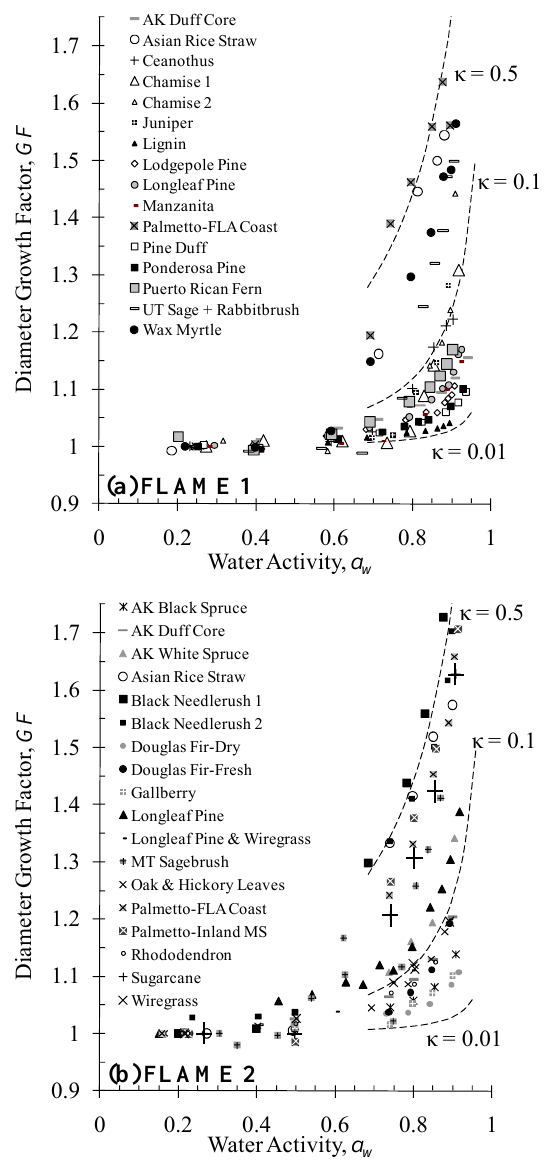
Figure 4. Compilation of chamber burn ensemble GF as a function of a w for D d = 100 nm particles 3 Fig. 4. Compilation of chamber burn ensemble GF as a func- tion of a w for D d =100nm particles during (a) FLAME 1 and (b) during (a) FLAME 1 and (b) FLAME 2. Error bars indicating the estimated uncertainties of the 4 FLAME 2. Error bars indicating the estimated uncertainties of the measurement are shown in panel (b) for sugarcane. (AK=Alaska, measurement are shown in panel (b) for sugarcane. (AK=Alaska, FLA=Florida, MS=Mississippi, 5 FLA=Florida, MS=Mississippi, MT=Montana,UT=Utah).6